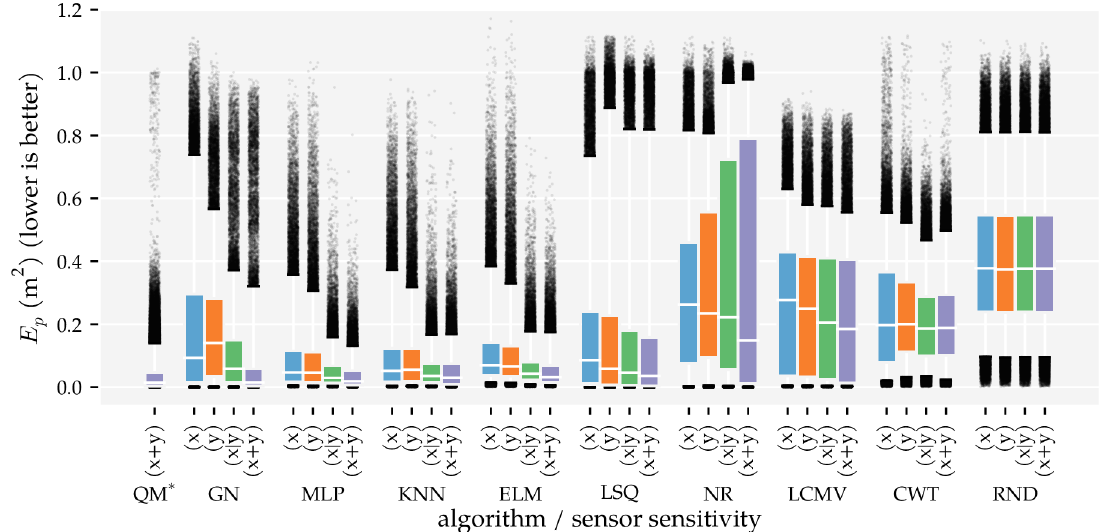
Figure 11. Boxplots of the position error distributions for all algorithms in the second analysis method. This analysis varied the sensitivity axes of the sensors: (x + y) measured both velocity components at all sensors, (x|y) alternated measuring v x and v y for subsequent sensors, (x) measured only v x at all sensors, (y) measured only v y at all sensors. The D s = 0.01 training and optimisation set and σ = 1.0 × 10 − 5 ms − 1 noise level were used. The whiskers of the boxplots indicate the 5th and 95th percentiles of the distributions. Predictions with errors outside these percentiles are shown individually. QM* is based on the D s = 0.01 condition in Analysis Method